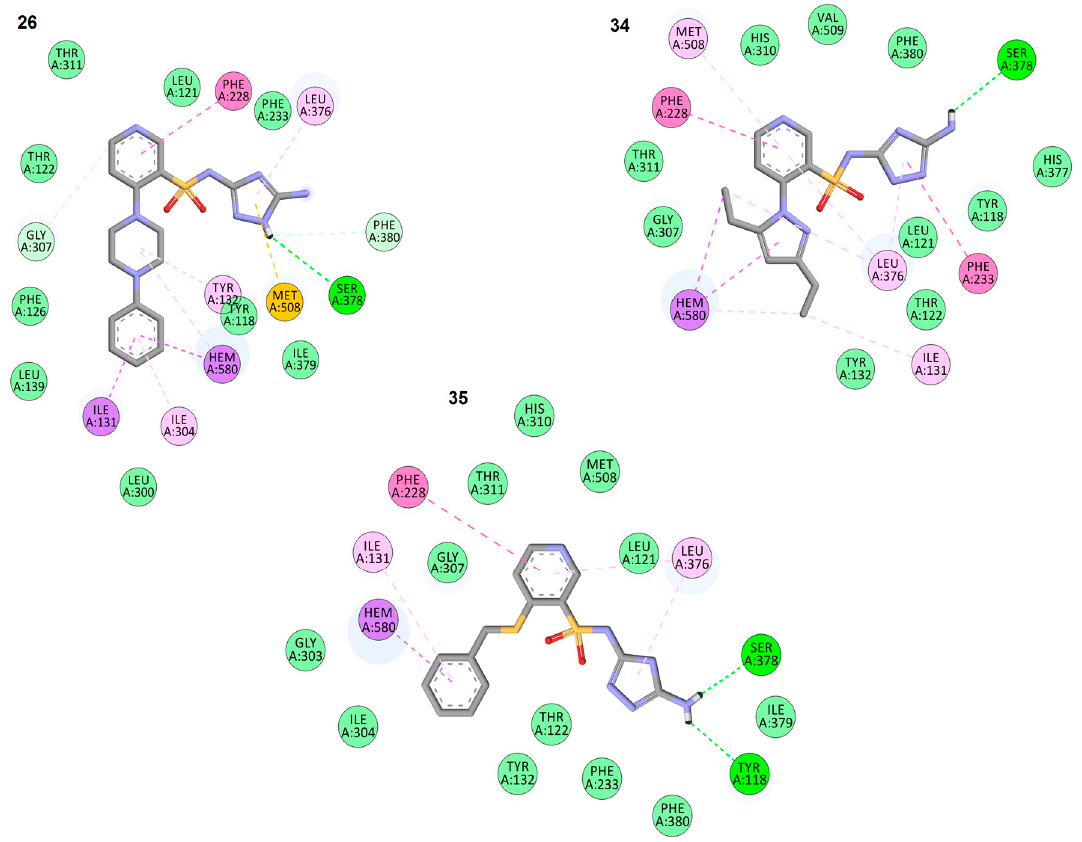
Figure 3. The two-dimensional presentation of enzyme-ligand interaction of compounds 26 , 34 and 35 and the active site of CYP51 (PDB ID:5FSA).